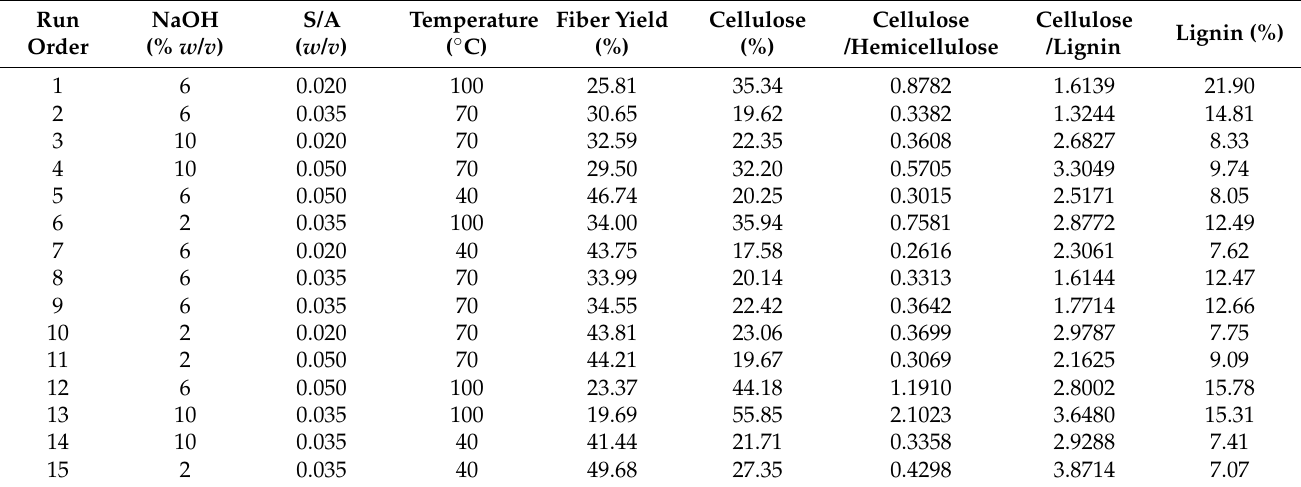
Table 2. Used factors and measured responses of the experimental